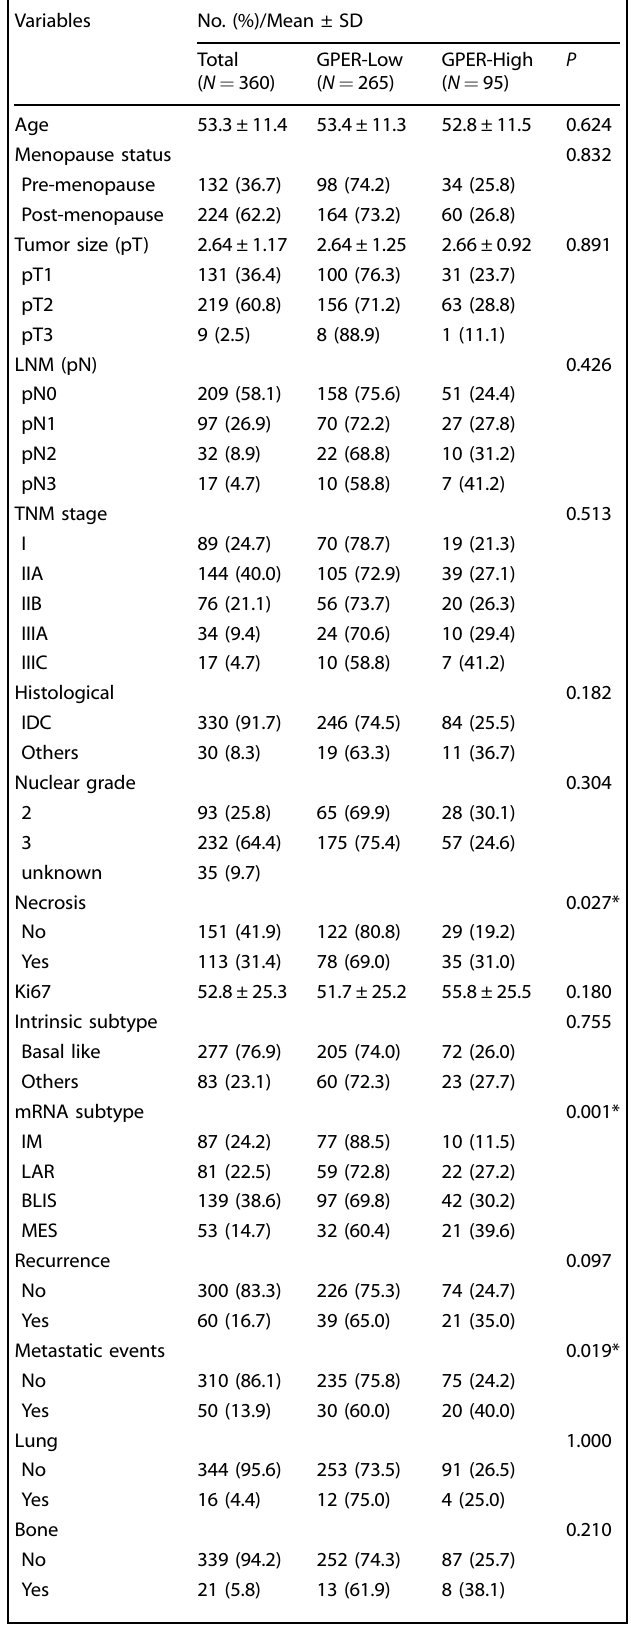
Table 1. Tumor characteristics and GPER distribution.